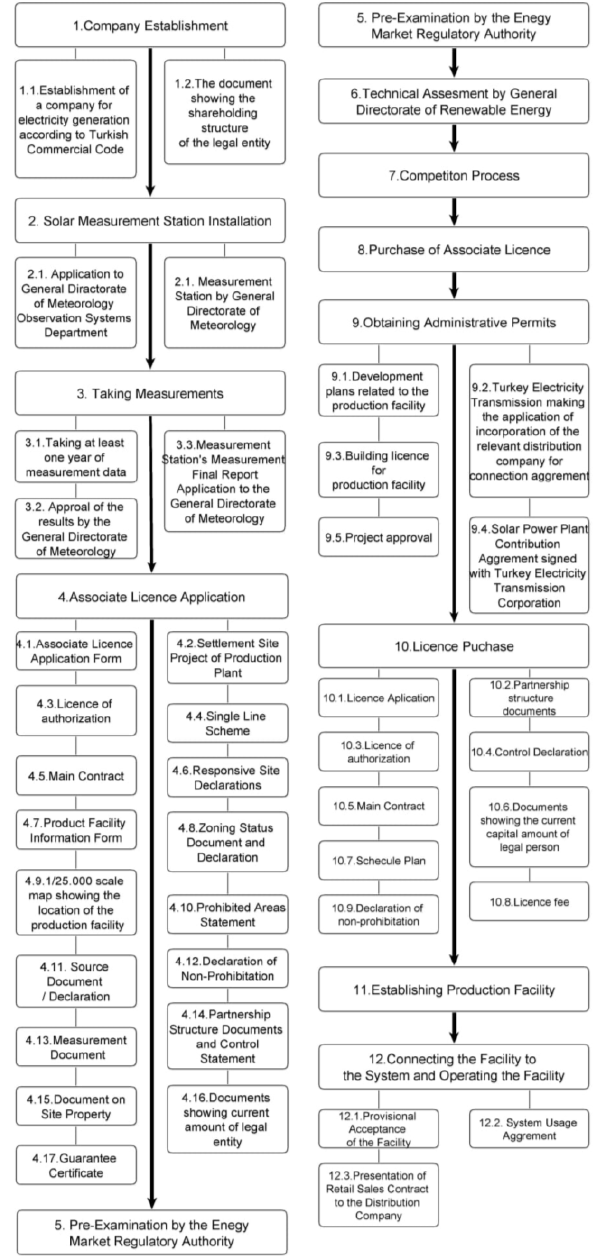
Figure 4. Implementation Steps for The Generation of Licenced Electricity from Solar Energy